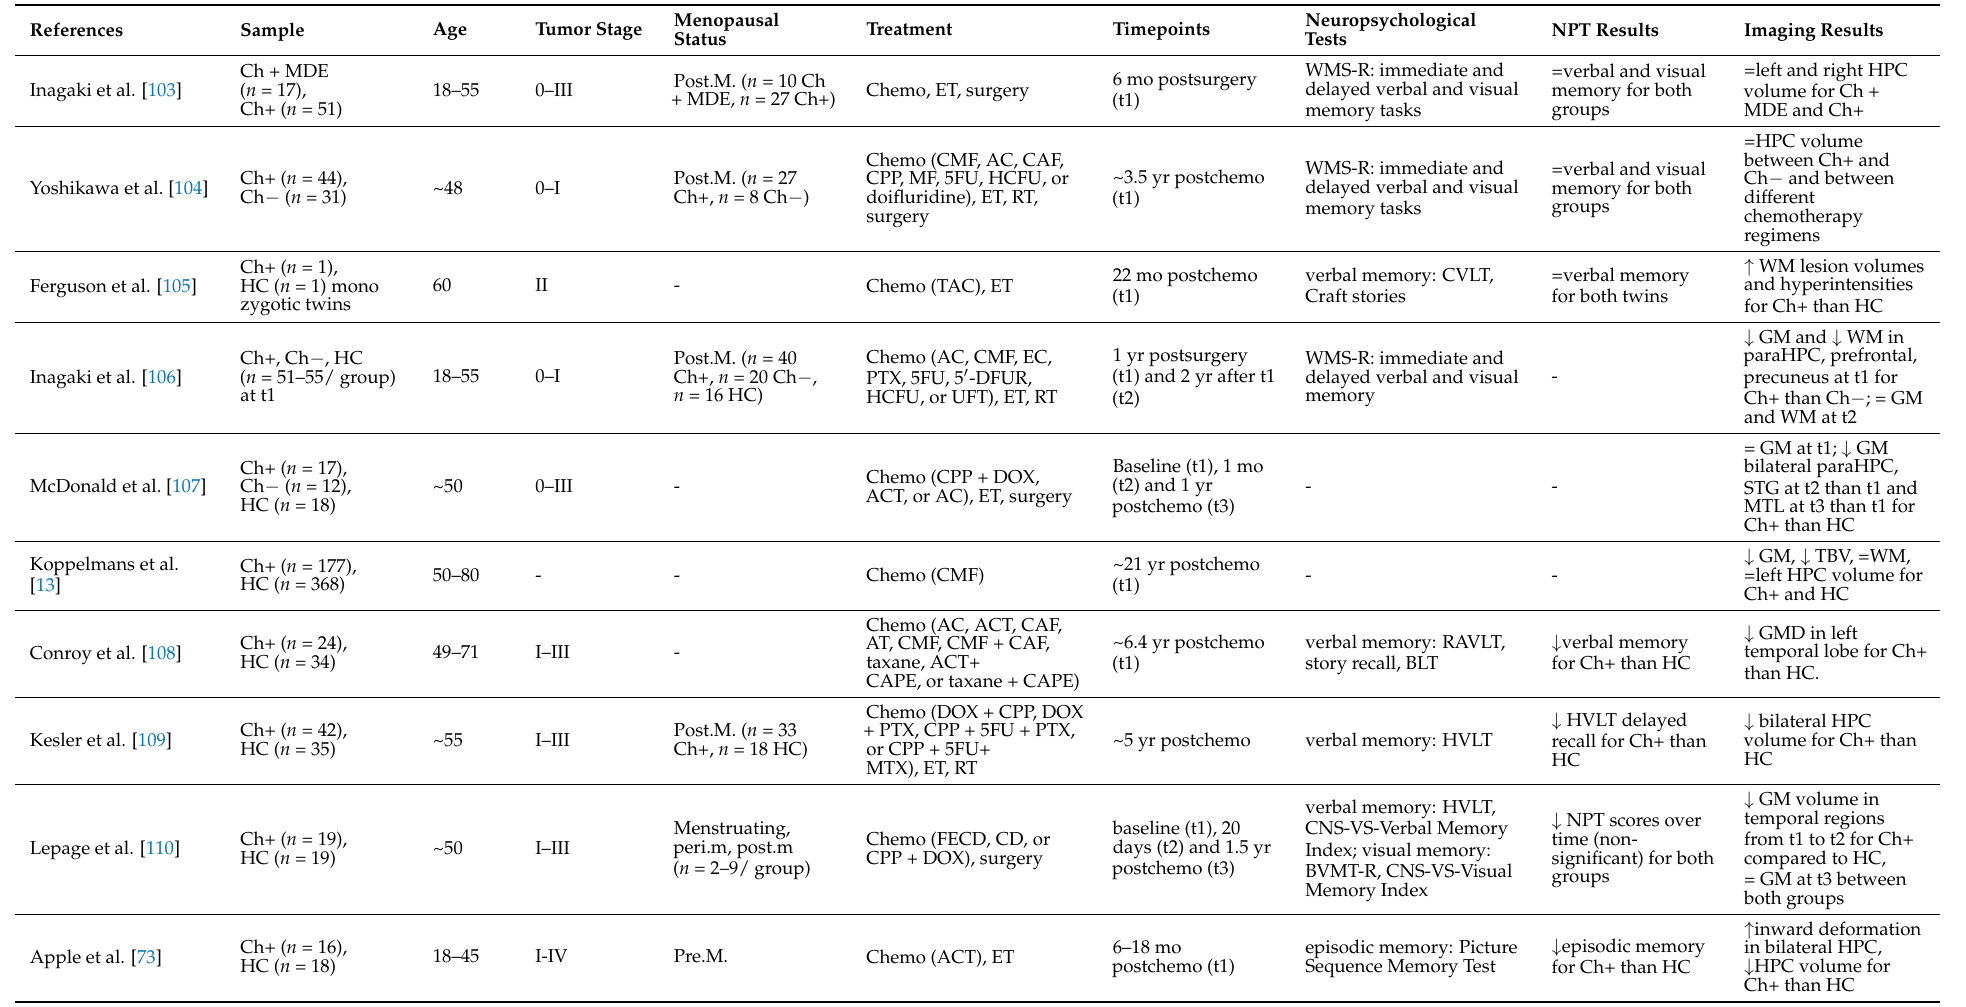
Table 1. Summary of reports identifying chemotherapy-induced structural differences in the temporal lobes using MRI and associated memory disruption in breast cancer